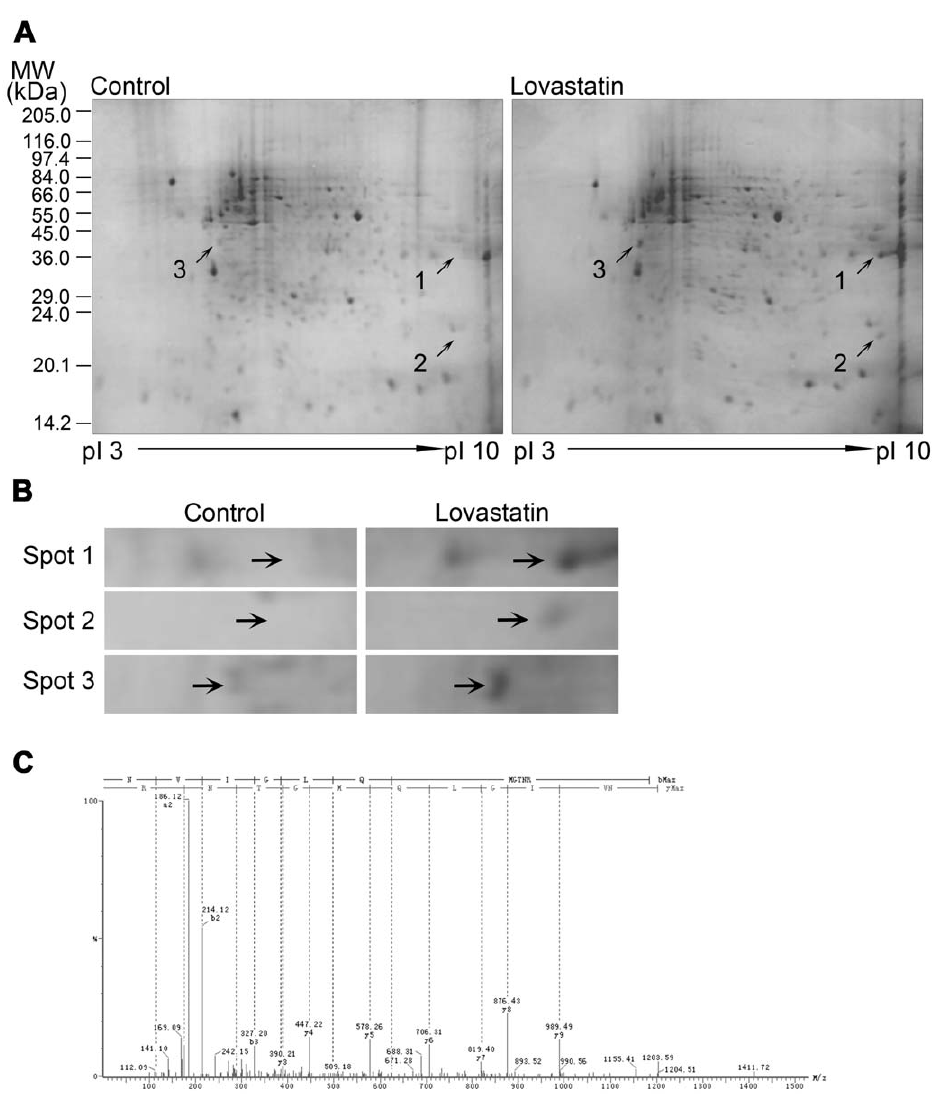
Figure 2. Identification of proteins differentially expressed in response to lovastatin treatment. (A) Representative 2D difference gel electrophoresis (DIGE) images of HUVECs treated with lovastatin (10 m M, 24 h) or vehicle. Among the differentially expressed protein spots, three major spots were selected (arrows). (B) Detailed views of spot 1, 2 and 3 (arrows). (C) The spot 2 was identified as transgelin 2 by ES-Q-TOF-MS analysis followed by database searching, with a Mascot score of 69 and sequence coverage of 16%. The fragment ion spectrum of spot 2 is